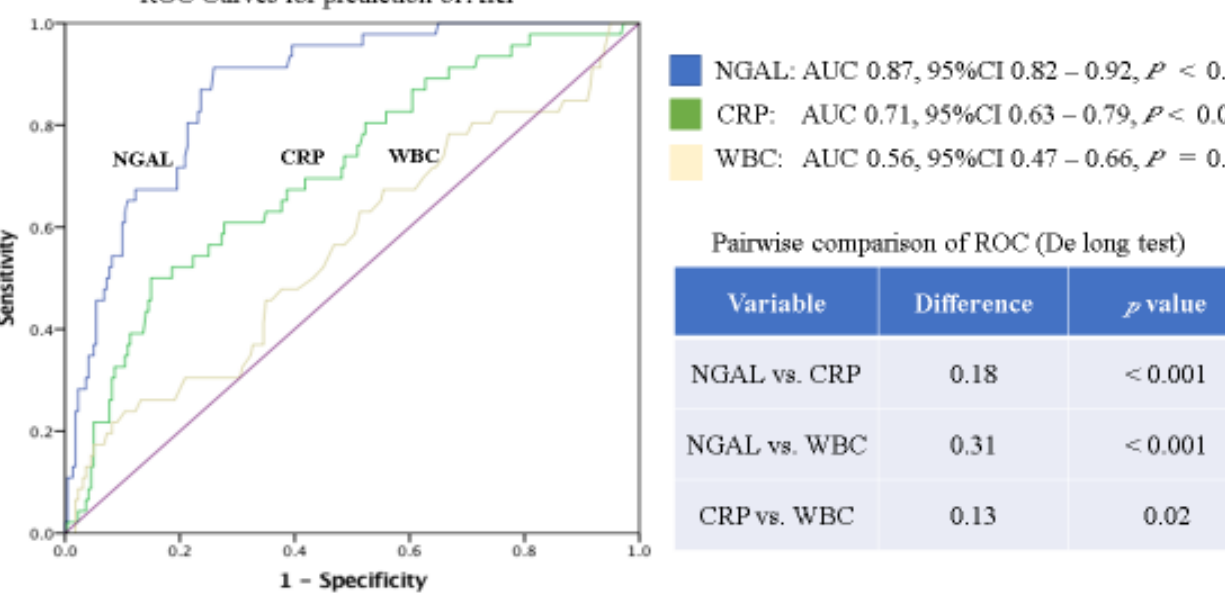
Figure 2. ROCs and corresponding AUCs of inflammatory laboratory markers for prediction of AKI; NGAL, neutrophil gelatinase-associated lipocalin; CRP, C-reactive protein; WBC, white blood cells.